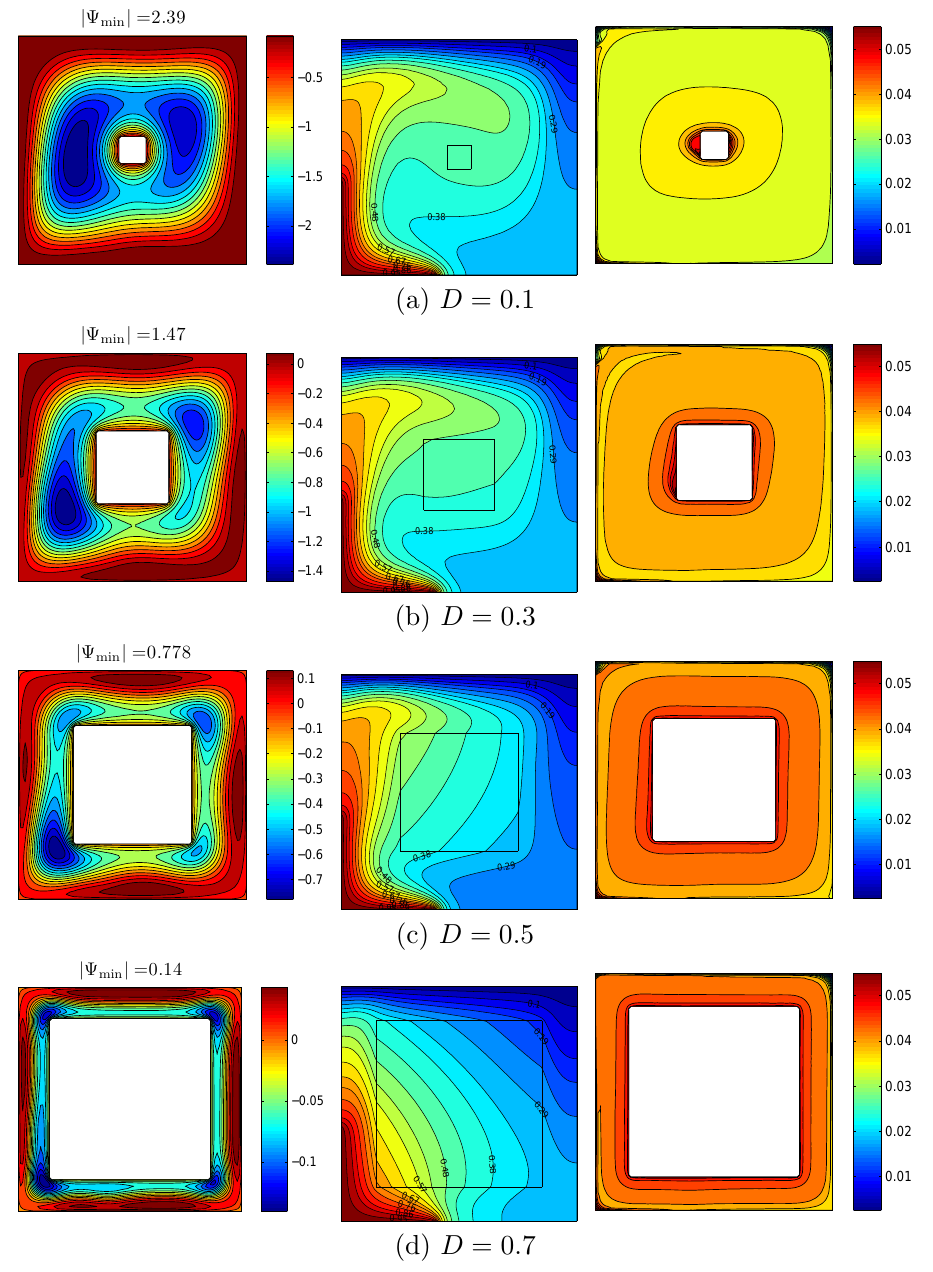
Figure 9. Variations of the streamlines ( left ), isotherms ( middle ), and nanoparticle distribution ( right ) evolution by the length of the inner solid square ( D ) for Ra = 10 5 , φ = 0.02 and k w = 0.76. ( a ) D = 0.1; ( b ) D = 0.3; ( c ) D = 0.5; ( d ) D =